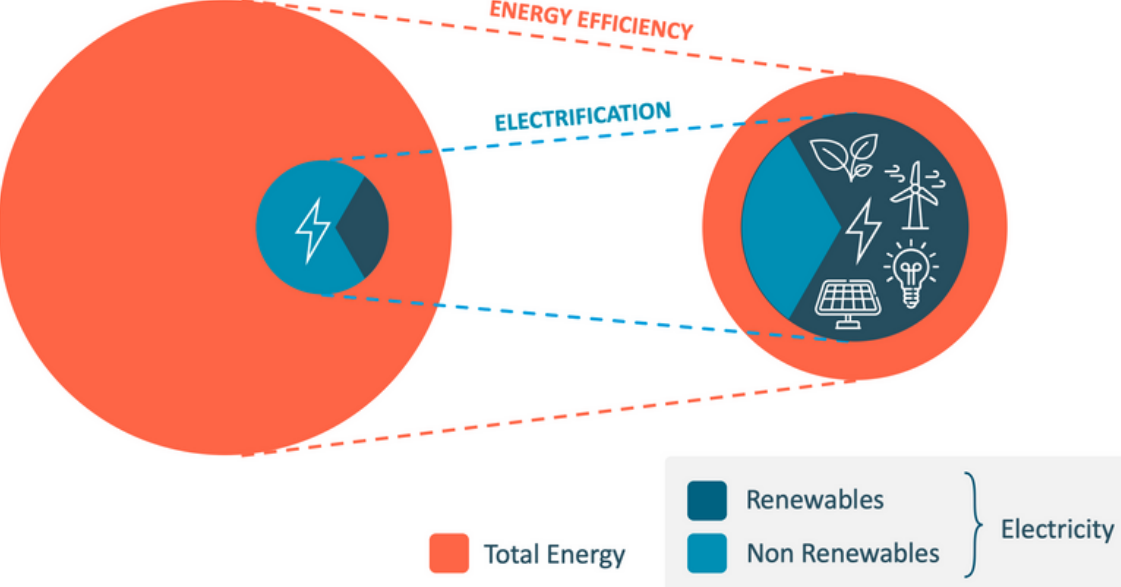
Figure 1. The expected evolution of the global energy system in the coming decades. Adopted from Elia